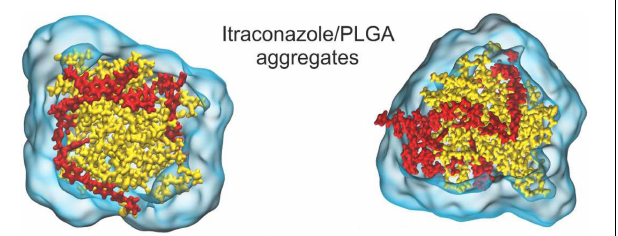
FIGURE 13 | Molecular dynamics (MDs) simulation showing ( A , left) 12% w/w and ( B , right) 24% itraconazole loading in a PLGA nanoparticle, adapted with permission from Wilkosz et al. (2018). Copyright (2019) American Chemical